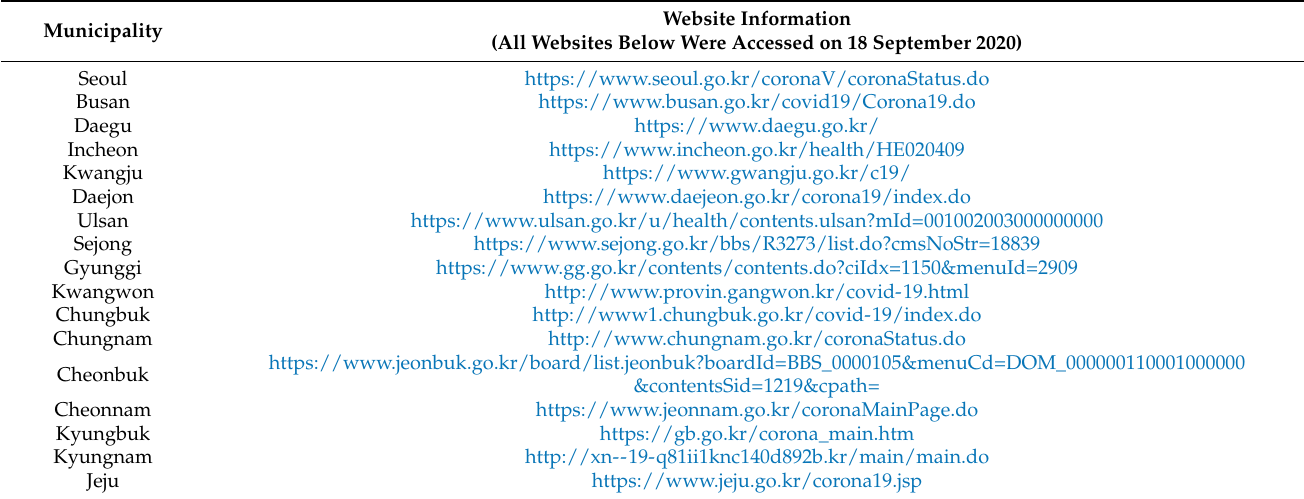
Table 1. Website information on the COVID-19 data set provided by